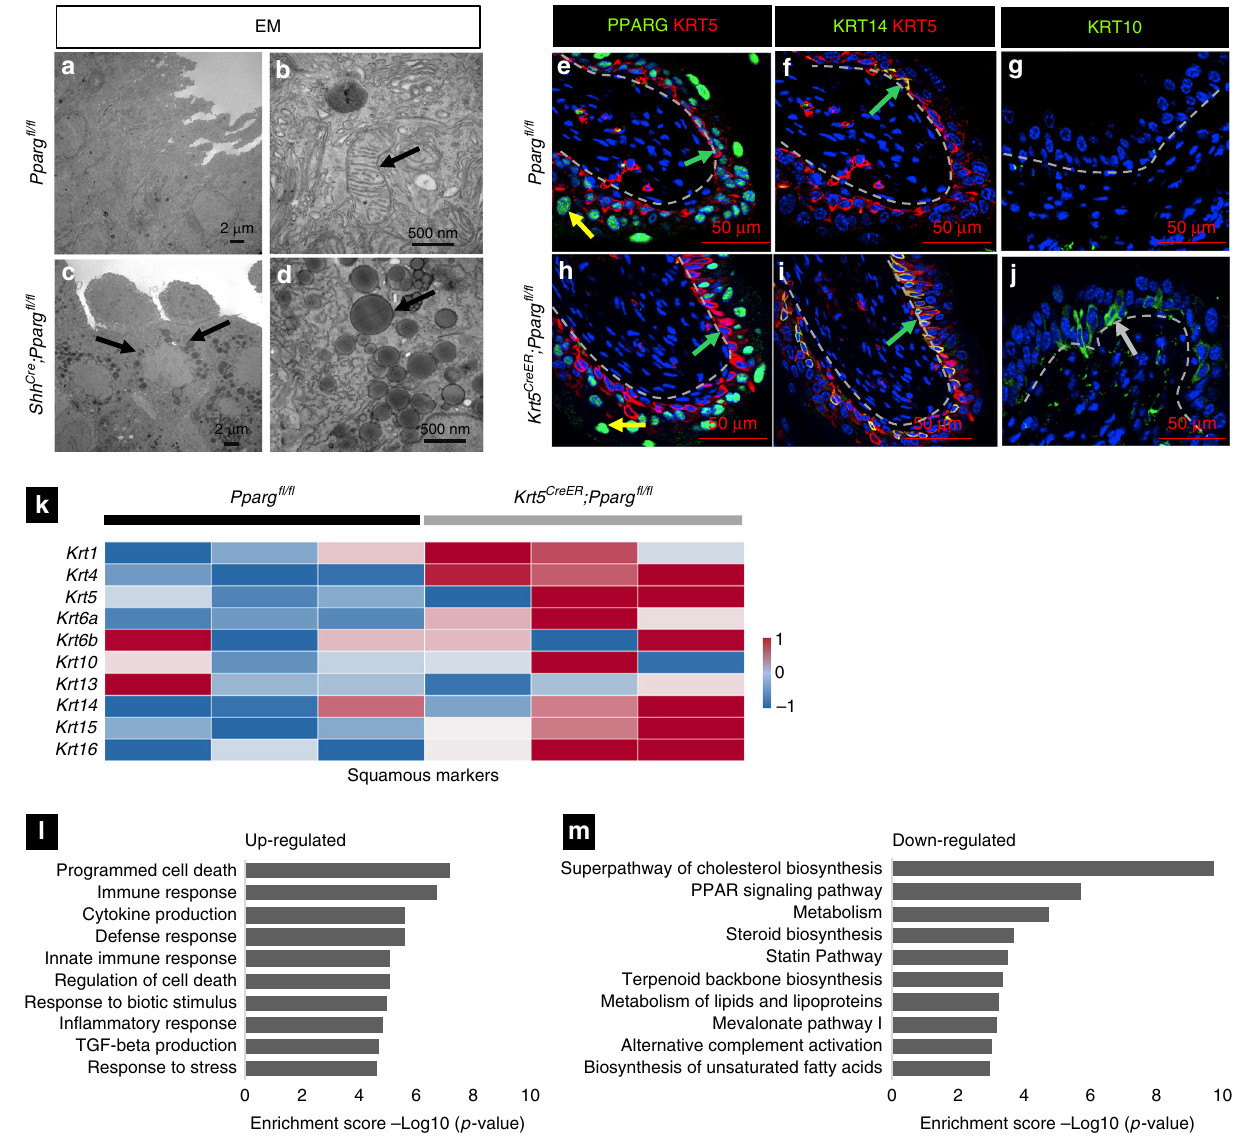
Fig. 8 Pparg ablation in basal cells results in squamous differentiation. a – d Transmission electron microscopy of the urothelium from adult Pparg fl / fl controls ( a , b ) and Krt5 CreER ;Pparg fl / fl mutants ( c , d ). a , c Low magni fi cation images showing inclusions detected in basal cells in the urothelium of c Shh Cre ; Pparg fl / fl mutants but not a adult Pparg fl / fl controls. b , d Higher magni fi cation images focusing on the inclusions in basal cells in the urothelium of d Shh Cre ; Pparg fl / fl that are absent in b adult Pparg fl / fl controls. This fi gure shows mitobodies in basal cells that have similar features as those observed in S cells. Scale bar: a , c 2 μ m; b , d 500 nm. e – j Expression of squamous markers in the Pparg fl / fl control mice and Krt5 CreER ;Pparg fl / fl mutant mice 14 days after tamoxifen induction. Pparg and Krt5 expression in a control ( e ) and in a Krt5 CreER ;Pparg fl / fl mutant ( h ). Krt14 and Krt5 expression in a Pparg fl / fl control ( f ) and in a Krt5 CreER ;Pparg fl / fl mutant ( i ). Krt10 expression in a control ( g ) urothelium and in the urothelium of a Krt5 CreER ;Pparg fl / fl mutant ( j ). Scale bars: e – j = 50 μ m. k Heatmap showing the changes in genes related to squamous differentiation in basal cells from Krt5 CreER ;Pparg fl / fl urothelium compared to the Pparg fl / fl control urothelium 14 days after tamoxifen induction. l – m Pathway enrichment analysis of genes l up-regulated and m down-regulated in basal cells from adult Pparg fl / fl controls compared to Krt5 CreER ;Pparg fl / fl mutants 14 days after tamoxifen induction. Numbers of samples used for EM; n = 3 adult Shh Cre ;Pparg fl /f l mutants and n = 3 Pparg fl /f l controls. Analysis of Krt5 CreER ;Pparg fl / fl mutants was performed with three mutants and three controls. RNA-Seq analysis of Krt5 CreER ;Pparg fl / fl was performed with samples from three mutants and three controls. Source data are provided as a Source Data fi